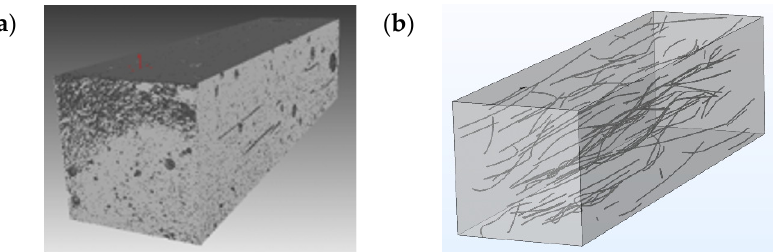
Figure 4. Representative volume element of size 950 µm × 950 µm × 3670 µm: ( a ) from µ-CT data, ( b ) reconstructed in COMSOL Multiphysics ® . The fibers of the RVE were extracted from µ-CT data and imported into COMSOL Multiphysics ® via LiveLink™ [34].